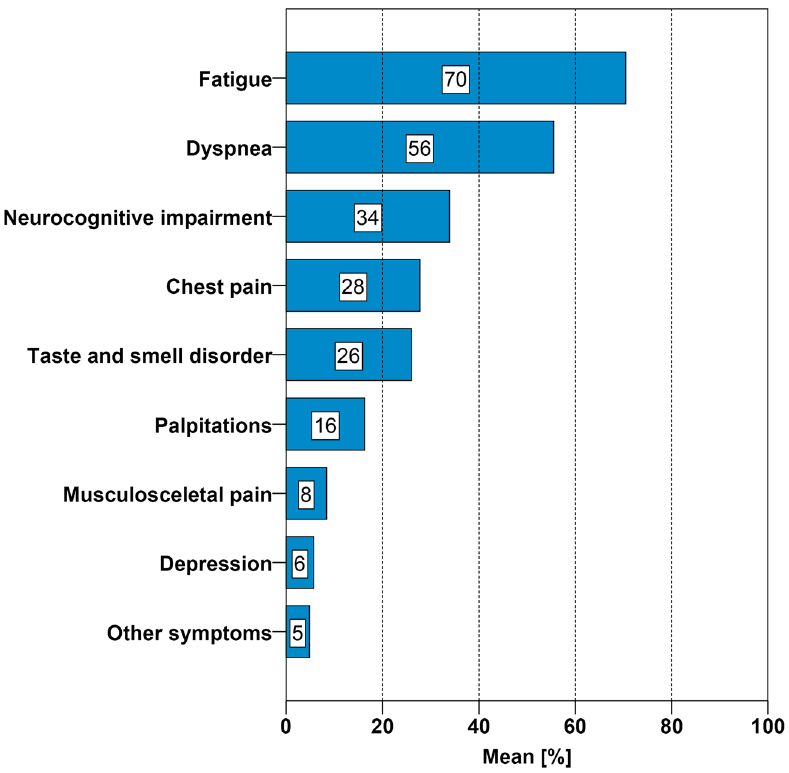
Figure 1. Symptoms at consultation. Prevalence of self-reported symptoms of ambulatory patients with post- COVID-syndrome, n =